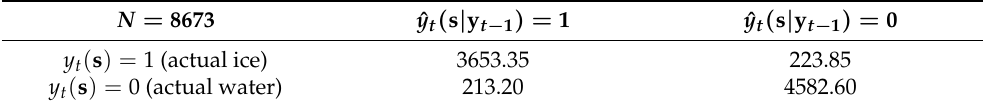
Table A4. Time-averaged 2 × 2 confusion matrix for